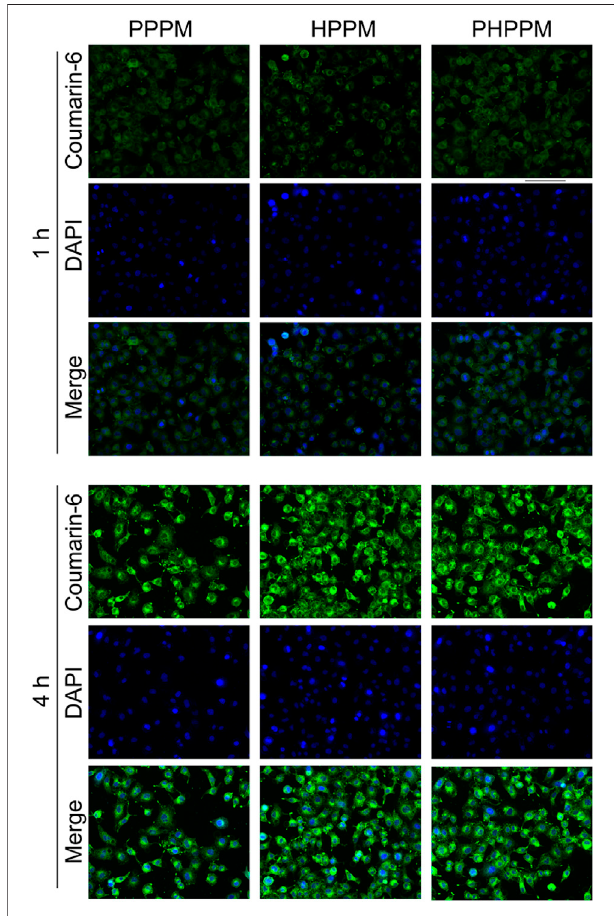
FIGURE 4 | Fluorescence images of Hep-2 cells after 1 or 4 h of treatment with coumarin-6 labeled PHPPM, HPPM, and PPPM.